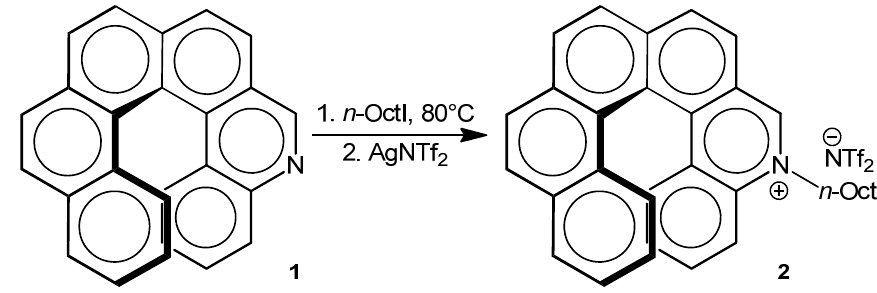
Scheme 4. Synthesis of ( P )-5-octyl-5-aza[6]helicenium bistriflimidate ( 2